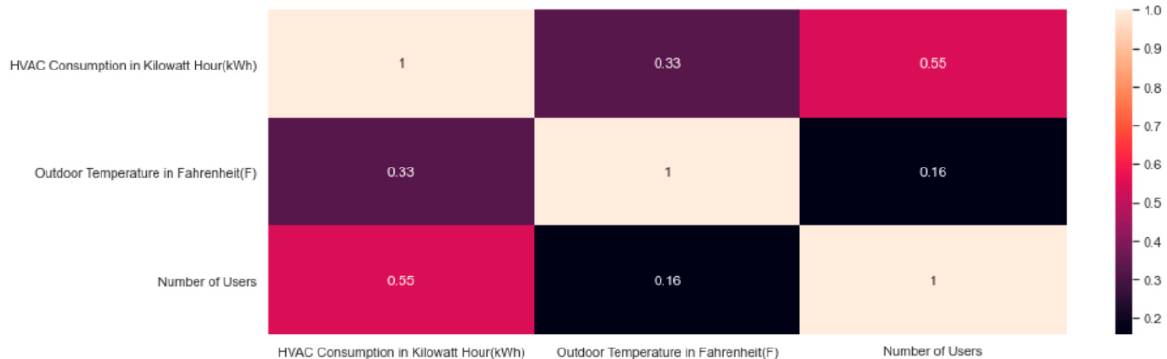
Figure 9. Correlation coefficients between the HVAC consumption, number of users, and outdoor temperature .